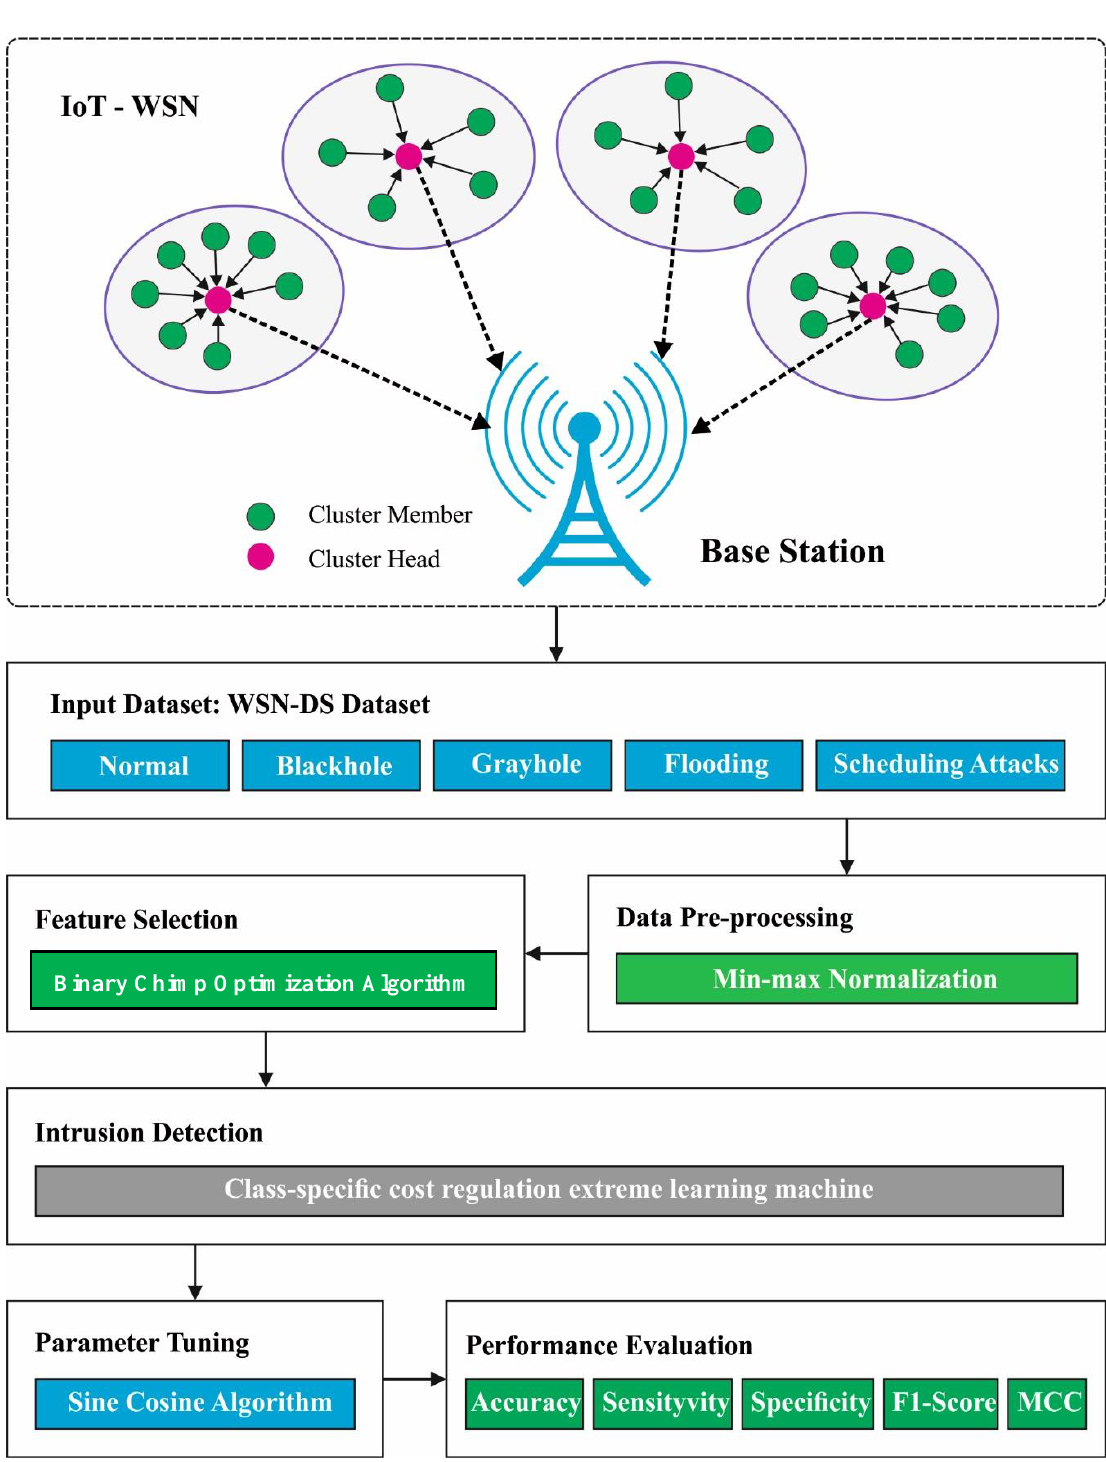
Figure 1. The overall flow of the BCOA-MLID approach.